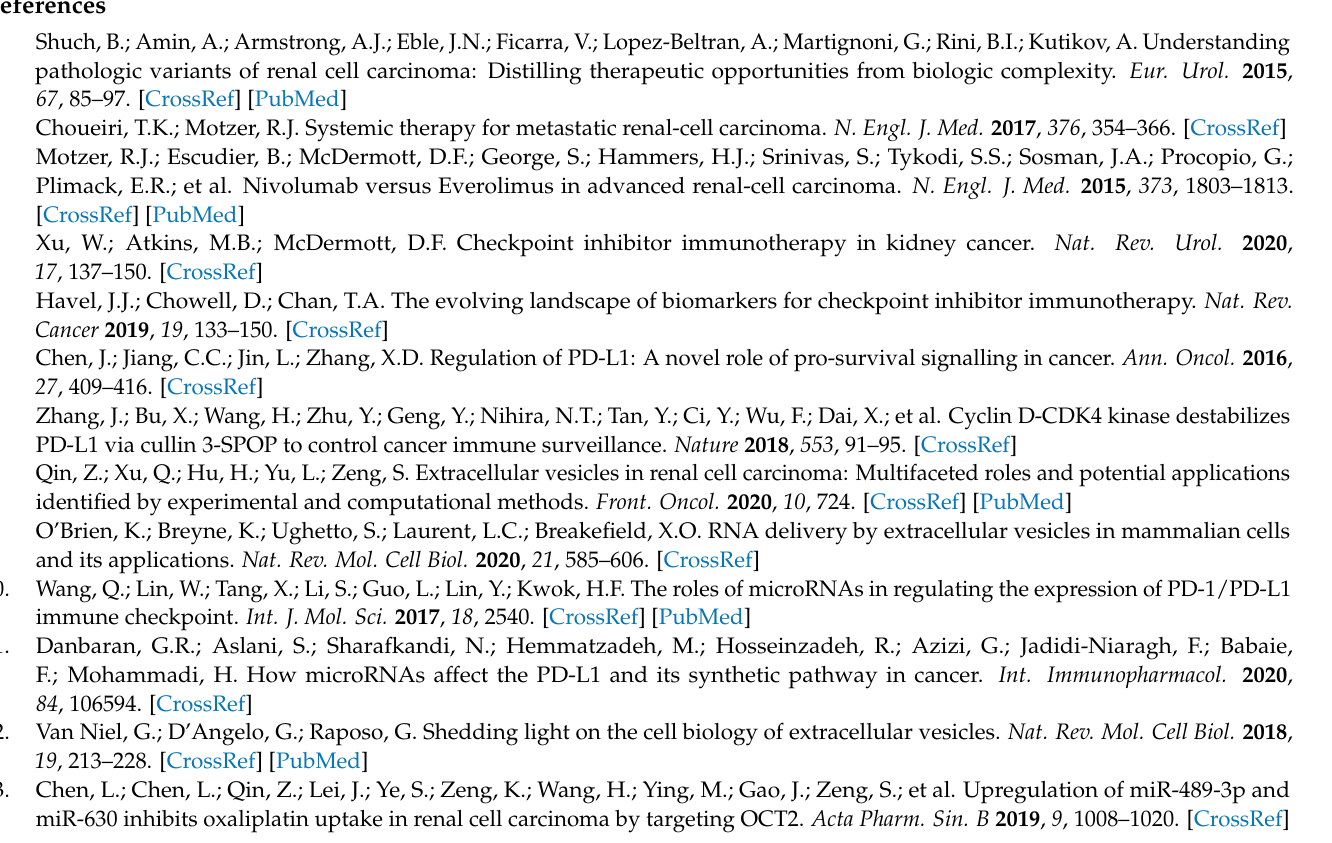
for 12 h. Figure S6: Construction and verification of miR-224-5p stably expressed RCC cells and EVs. (A) Protein levels of cyclin D1 and PD-L1 in miR-224-5p stable expressed RCC cells were detected by Western blot. (B) PD-L1 protein abundance in RCC-NC/miR-224-5p cells was detected by Western blot after transfection of NC (200 nM) and miR-224-5p (100 or 200 nM) inhibitors. (C) EV uptake assays were conducted by confocal microscope. Cell membrane, EVs and nucleus were labeled with Dil (red), PKH67 (green) and DAPI (blue), respectively. Scale bar, 100 µ m. Figure S7. Original Western blots of Figures 1C, 5D, 6A,D, 7B–D, S4, S5B,C, and S6A,B. Table S1: Specimen